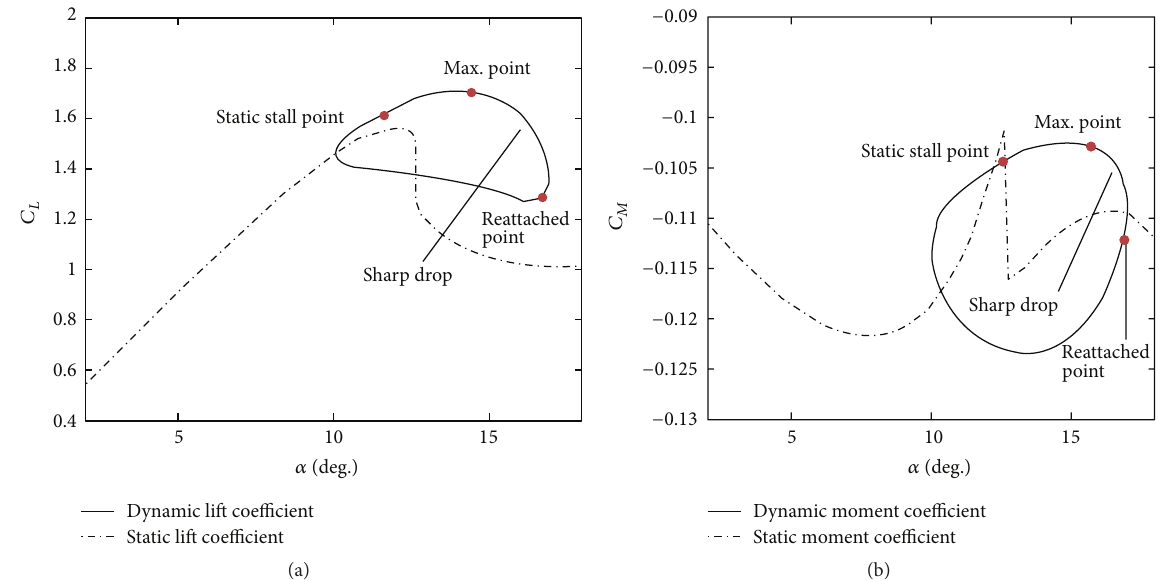
Figure 4: Deep dynamic stall simulated curve and static experimental data. (a) Lift force coefficient and (b) moment coefficient.